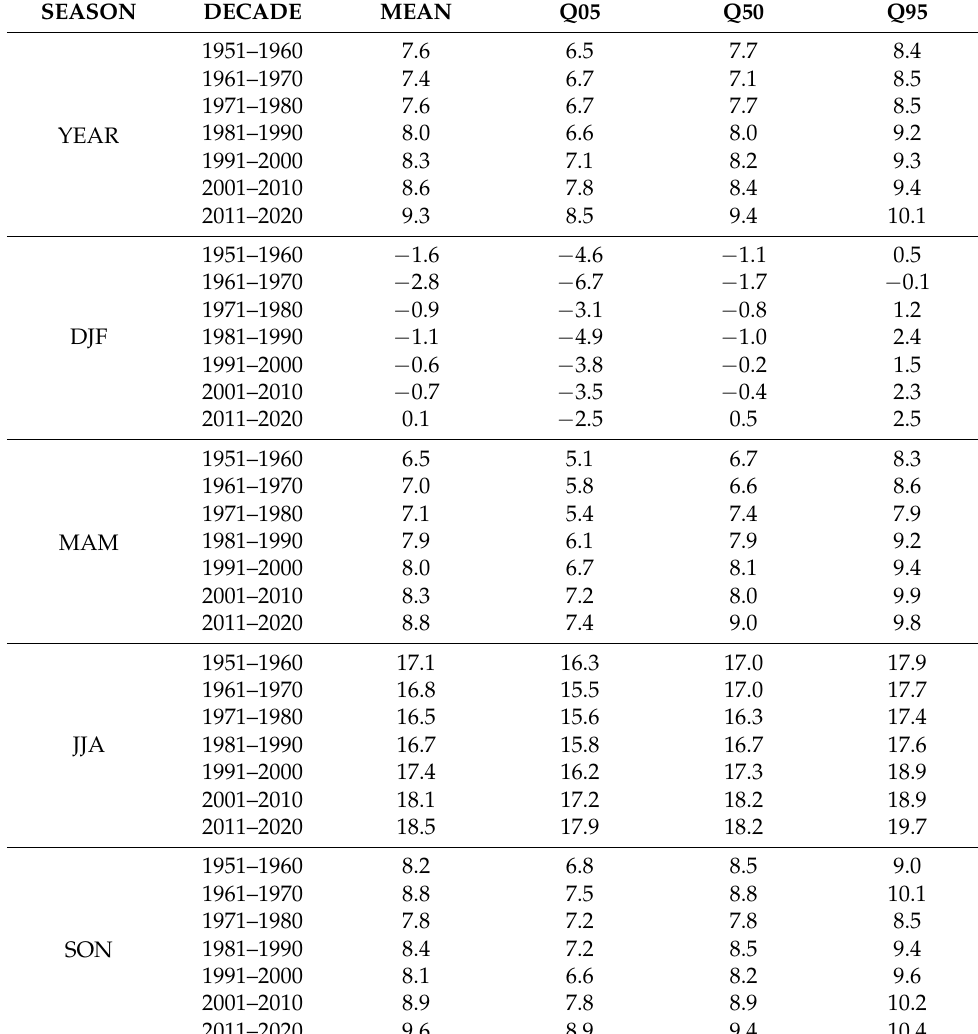
Table 2. Decadal characteristics of annual air temperature in Poland 1951–2020. Q05, 5% quantile; Q50, median; Q95, 95%